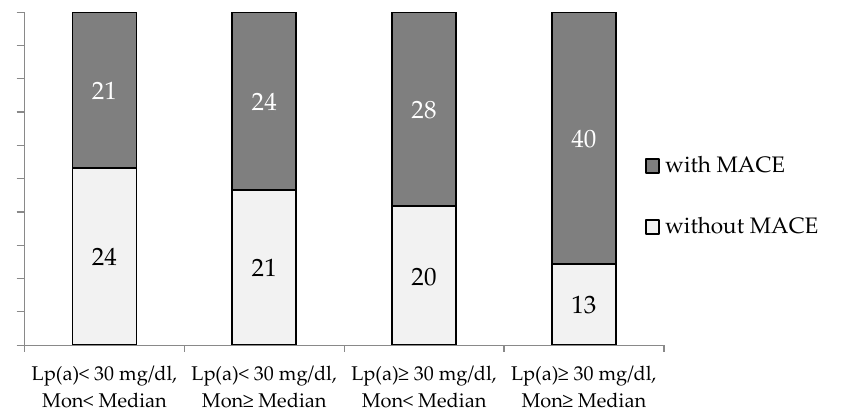
Figure 3. The proportion of CHD patients with and without MACE during observation period depends on blood monocyte count and Lp(a) concentration. Mon—monocytes. Median for Mon = 0.54 × 10 9 /L.